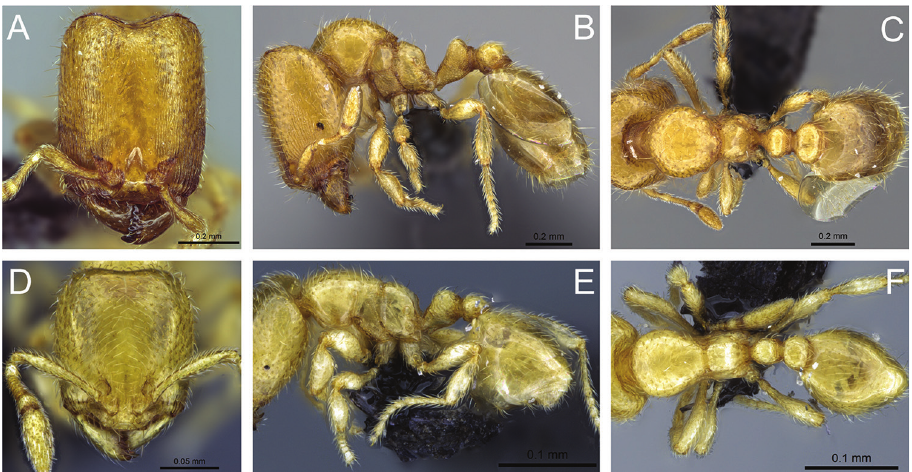
Figure 31. Carebara bara –holotype. Major worker, CASENT0483010. A head in full-face view B body in profile view C body in dorsal view. Minor worker, CASENT0482985 D head in full-face view E body in profile view F body in dorsal